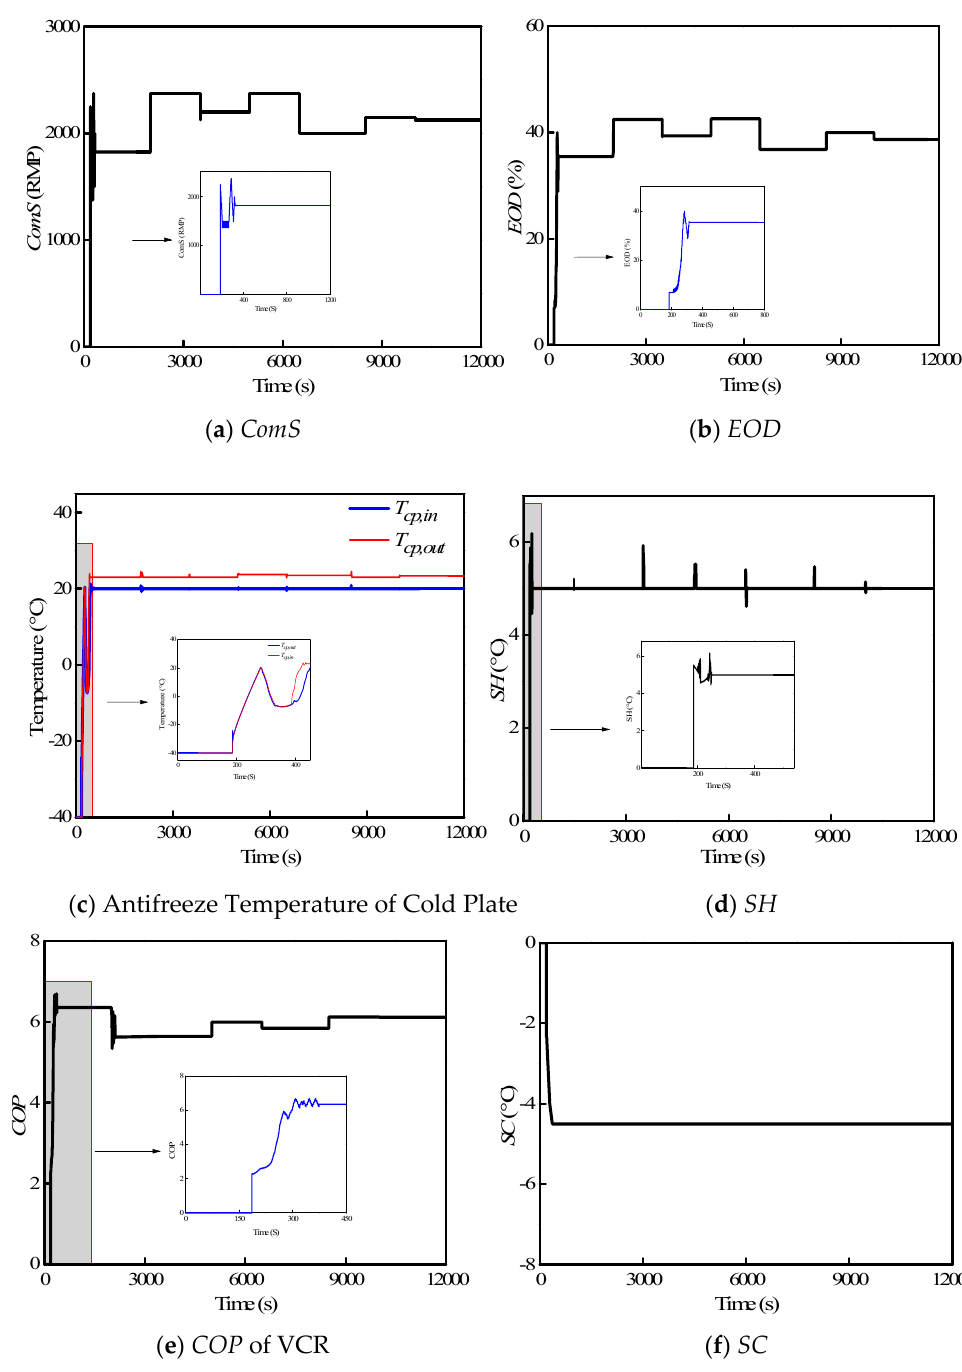
Figure 15. Control results in a cold day.